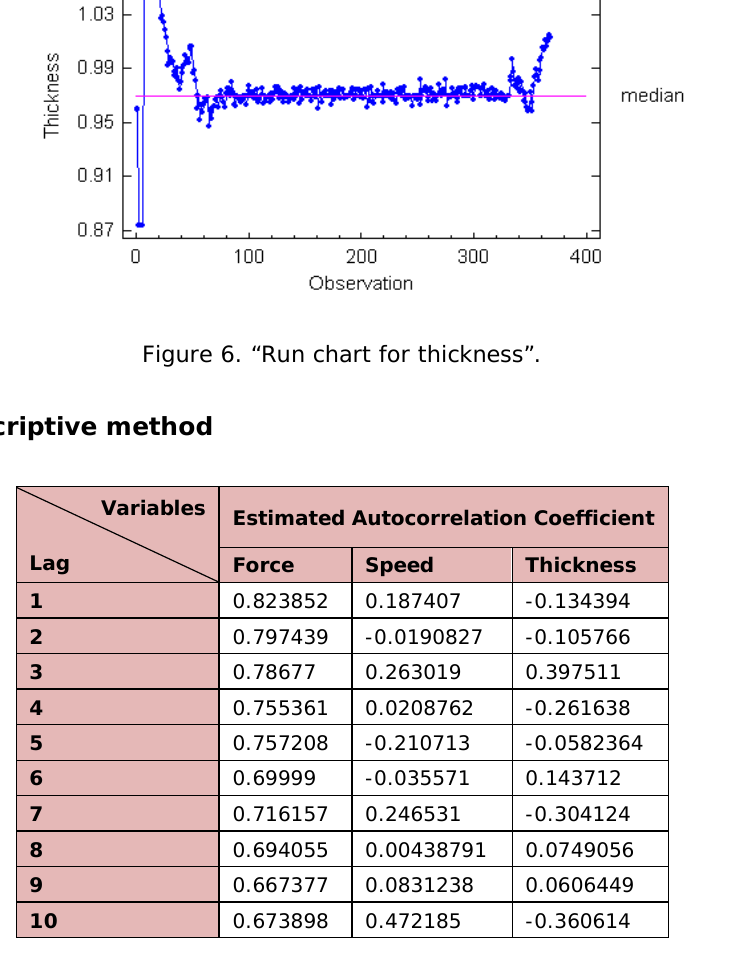
Table 2. “Estimated autocorrelation coefficients of force, speed and